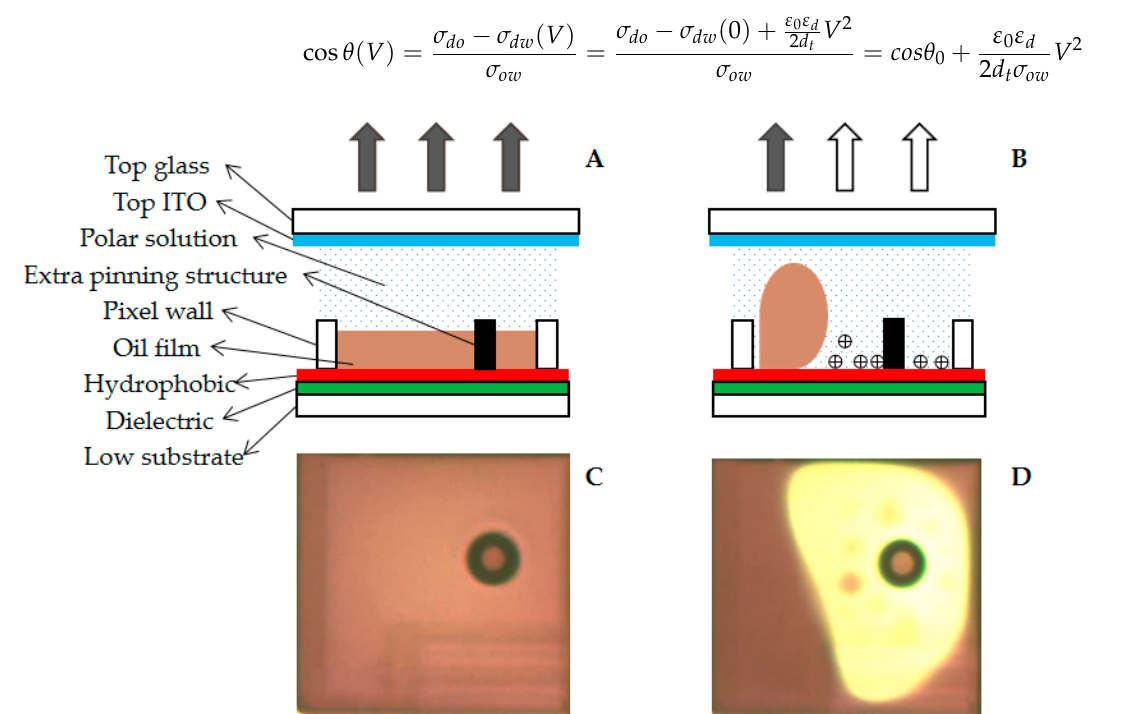
Figure 1. Structure of an EWD and the top view of an EWD under a microscope. ( A ) When no voltage is applied, the ratio of oil to water on the surface of the dielectric layer is 1:0 so that the pixel reflects the color of oil. ( B ) When a voltage is applied, the ratio of oil to water on the surface of the dielectric layer is 1:4 so that pixels mainly reflect the color of the reflective panel. ( C ) The top view of an EWD without a voltage applied; the oil is spread in the pixel. ( D ) The top view of an EWD with an applied voltage; the oil is pushed into a corner.